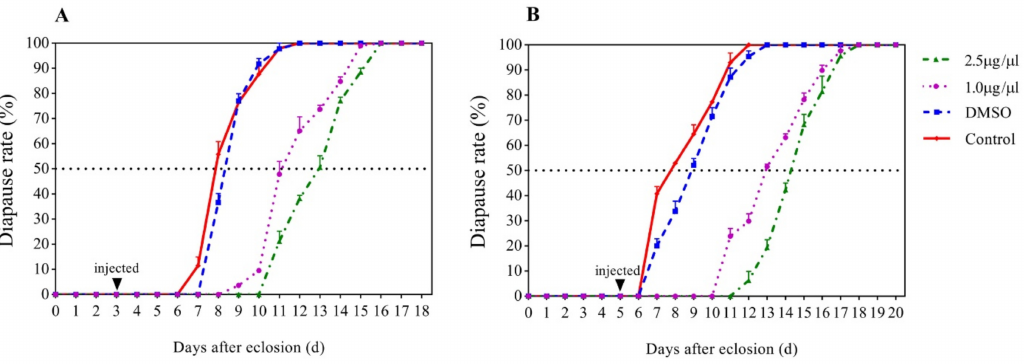
Figure 1. Effects of juvenile hormone analogue (JHA) JHA on diapause rates of G. daurica adults. ( A ) JHA application at 3 days post-eclosion. ( B ) JHA application at 5 days post-eclosion.